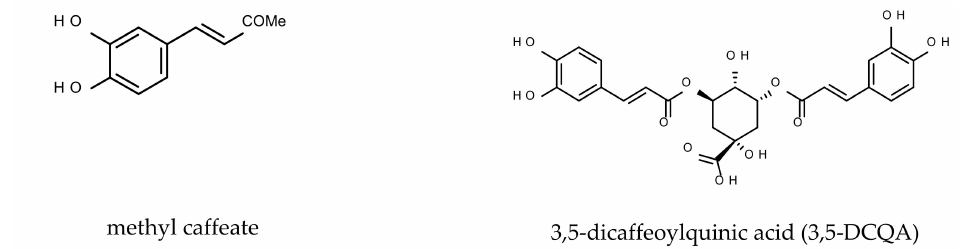
Figure 1. Chemical structure of methyl ca ff eate (MC) and 3,5-dica ff eoylquinic acid